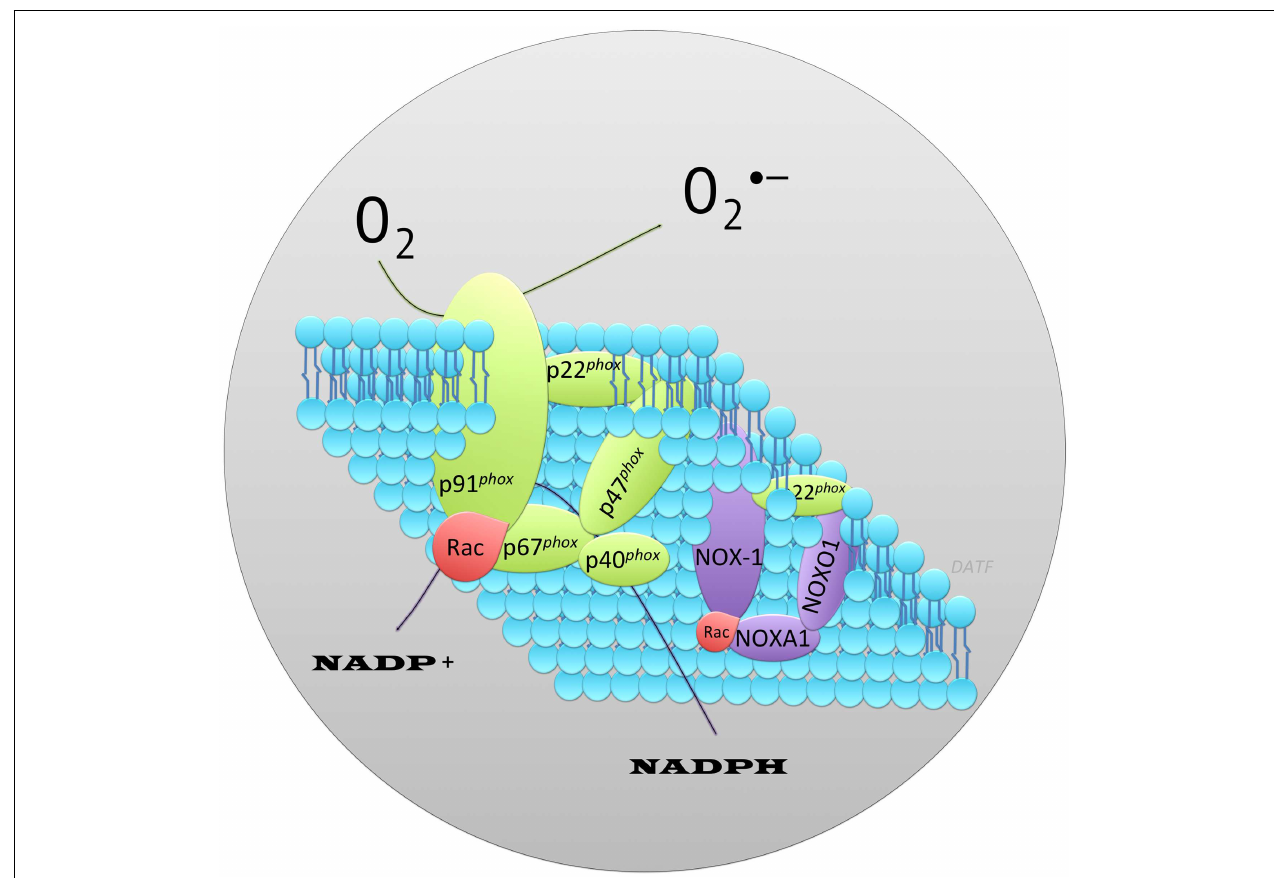
(shown red).These are required for a functional oxidase. Superoxide (O •− generated via a one electron reduction of oxygen by NADPH. By analogy, the functional NOX-1 enzyme consists of distinct protein subunits (shown in purple) in a complex with p22 phox (green) and Rac (red). NOX-1, the core catalytic component, interacts with homologs of p47 phox and p67 phox called NOXO1 (NOX Organizer Protein 1) and NOXA1 (NOX Activator Protein 1)